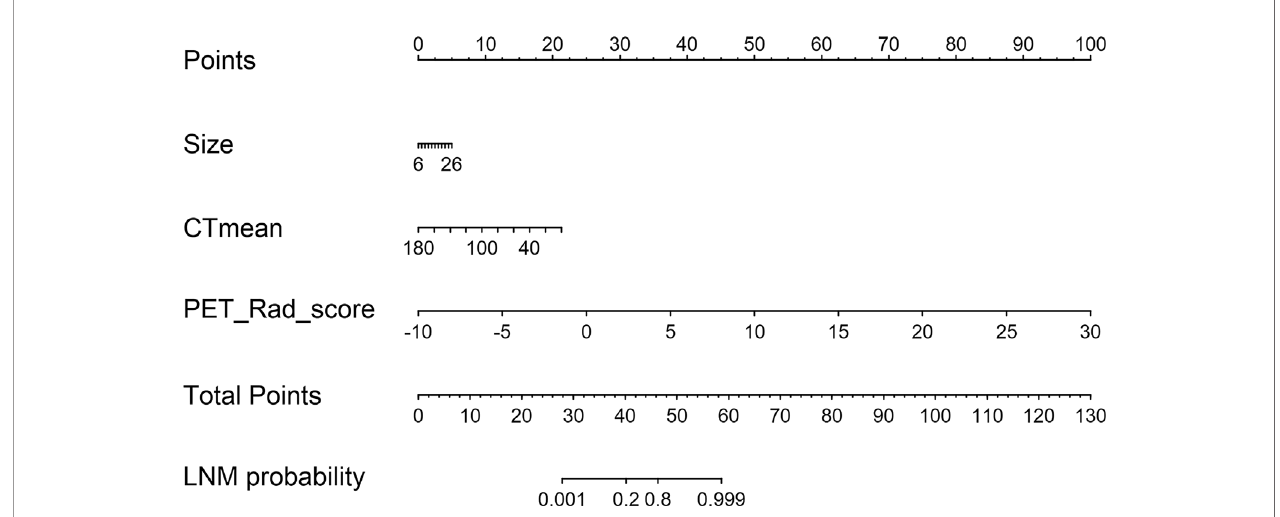
FIGURE 4 | A radiomics nomogram was developed incorporating PET Rad_score with conventional CT images (size and CTmean) in the training